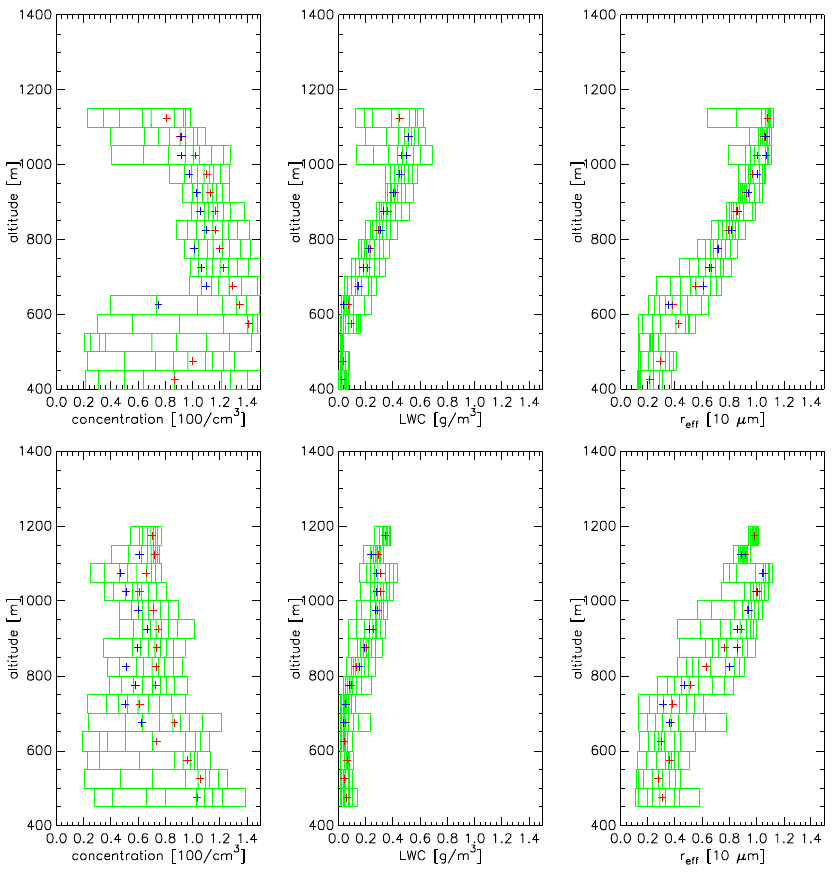
Fig. 10. Statistics of cloud droplet spectrum plotted as a function of altitude for two research flights (RF51 – upper row, and RF52 – lower row) on 15 May above the North Sea in a Sc layer. A cumulative distribution of cloud droplet number concentration, liquid water content and effective radius on each level is represented by a set of 7 percentiles (1/8, 2/8, 3/8, 4/8, 5/8, 6/8 and 7/8) using vertical bars. The analysis carried out separately for regions with a positive ( w> 0) and negative ( w< 0) vertical velocity shows median valuse marked by a green ( w< 0) and red ( w> 0)